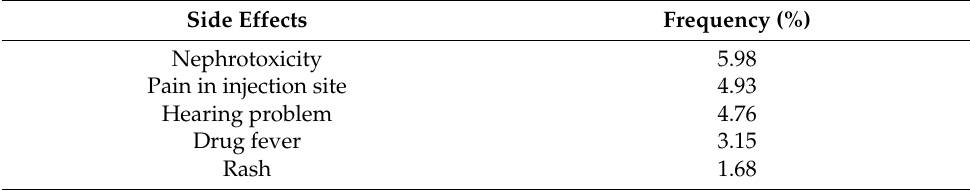
Table 3. Most common teicoplanin side